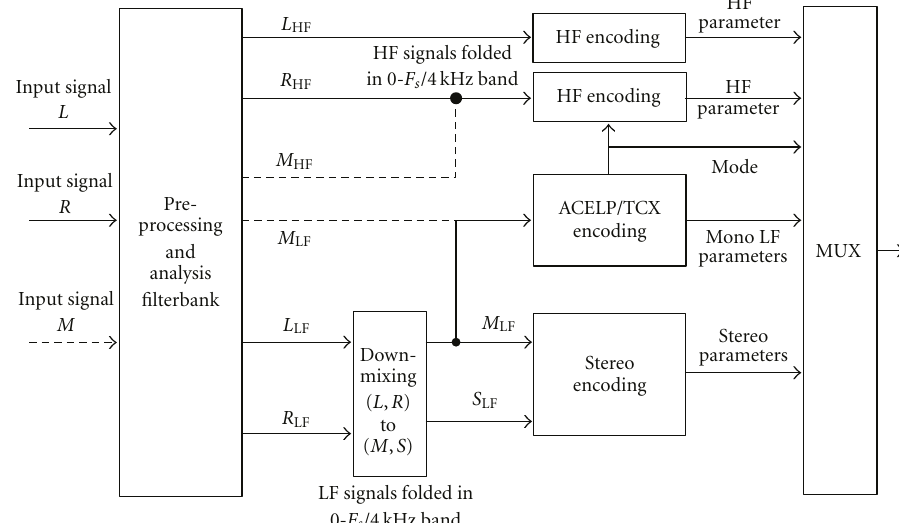
Figure 1: Structure of AVS-M audio encoder.